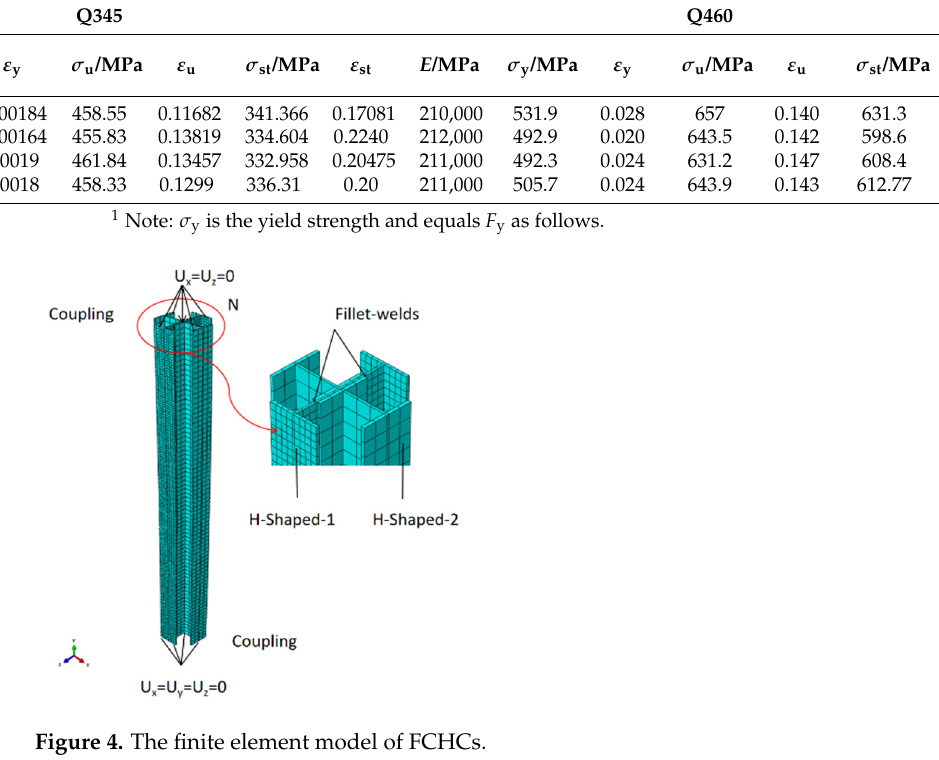
Table 2. Representative values of comprehensive imperfections of members (Table 5.2.2 in GB50017